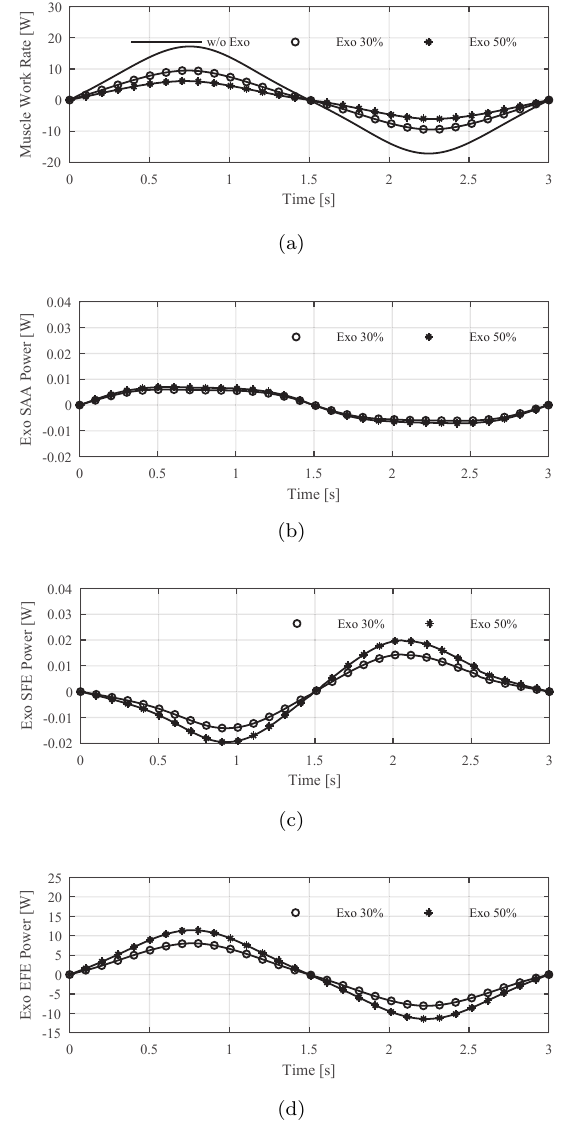
Figure 9: Energy flow in between the human and ex- oskeleton during the bicep curl depicted by: (a) the total muscle work rate, (b) the power consumption of the shoulder abb/abd, (c) the power consumption of the shoulder flex/ext, (d) the power consumption of the elbow